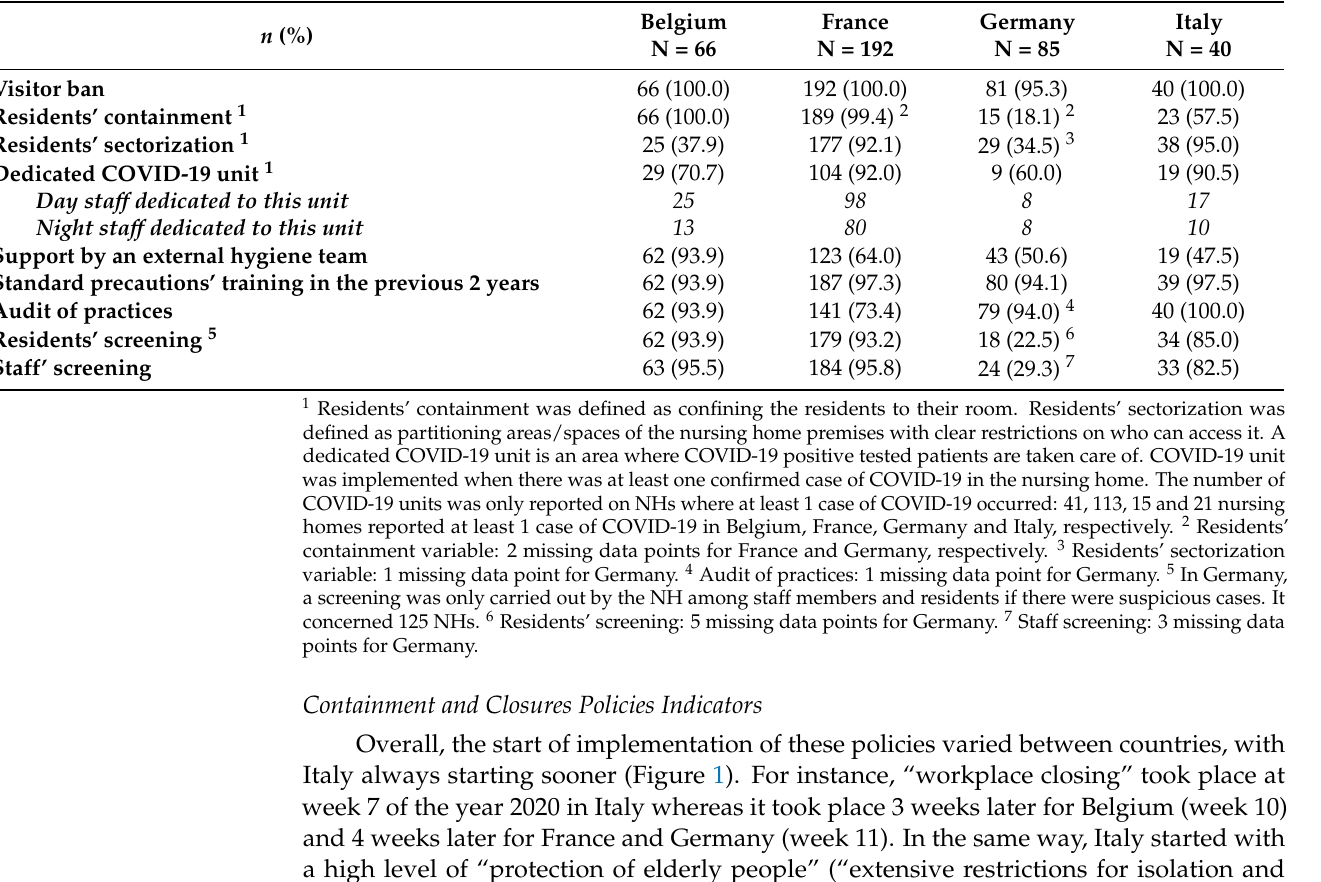
Table 2. Characteristics of prevention and control measures implemented in the nursing homes surveyed. CluDe Study,